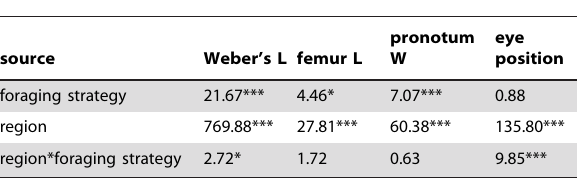
Table 1. F-values from REML ANOVA testing the effect of: a) habitat, treatment and their interaction (df = 1,3,3); and b) habitat, region and their interaction (bait cards only; df=1,2,2) on morphological features of ants.